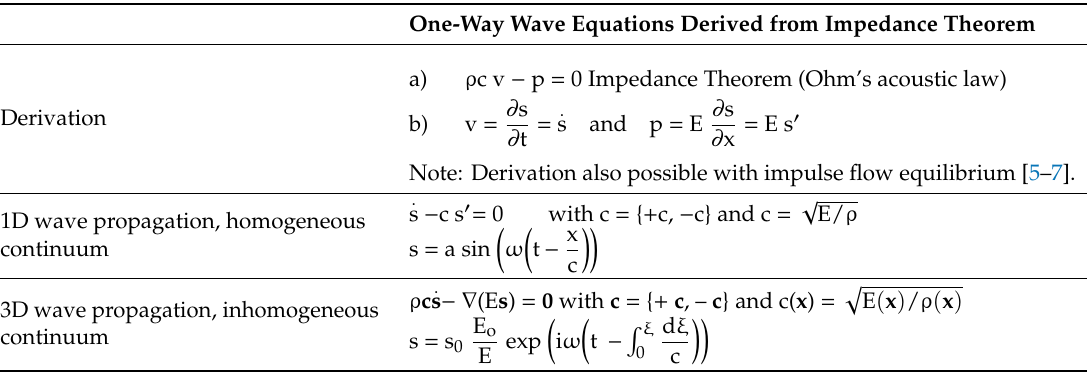
Table 2. Derivation of the One-way wave equation from impedance theorem, overview of